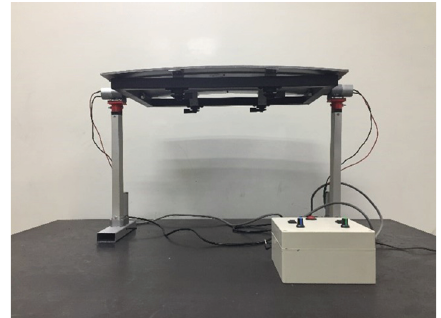
Figure 5: Stress distribution on the frame and vertical structure loaded with outer skin aircraft door.